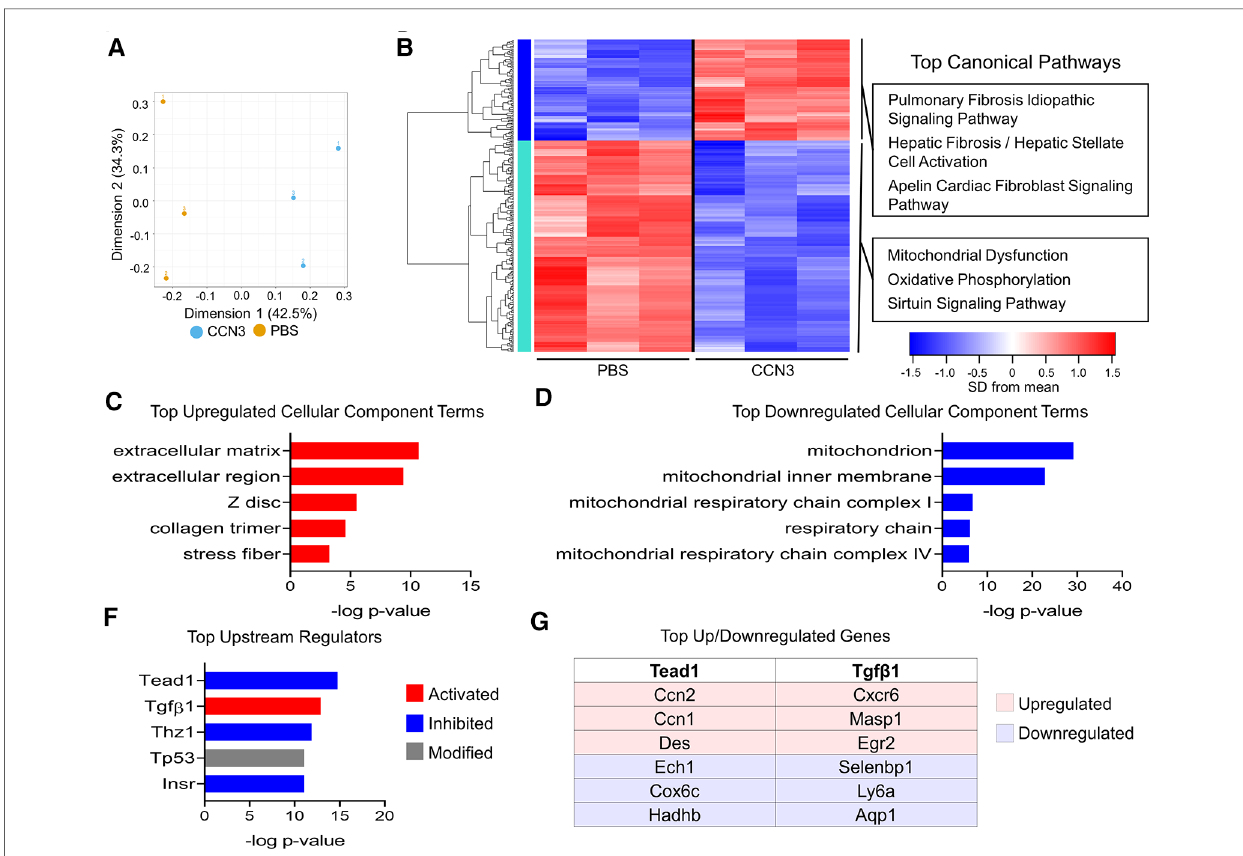
FIGURE 8 Ccn3 administration promotes fi brotic gene expression post MI. ( A ) PCA of DEGs from RNAseq from left ventricles. n =3 per group. ( B ) Heatmap of 309 genes with one-way ANOVA FDR P -value <0.2. The top three canonical pathways identi fi ed for each gene cluster by IPA are listed. ( C,D ) The top cellular component terms derived from upregulated (red) or downregulated (blue) DEGs derived from DAVID analysis. ( F ) The top upstream regulators from all DEGs predicted by IPA. ( G ) The top upregulated and downregulated genes by fold-change mediated by Tead1 or Tgf β